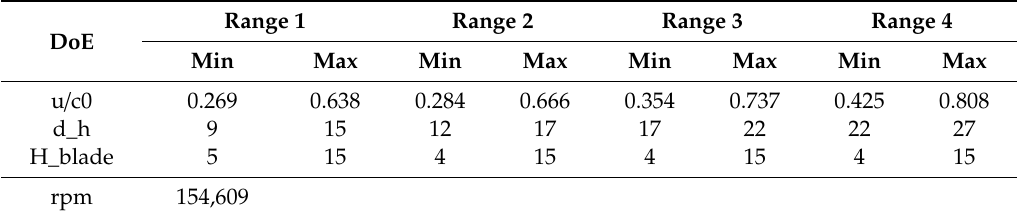
Table 2. Summary of Design of Experiment details for lower engine